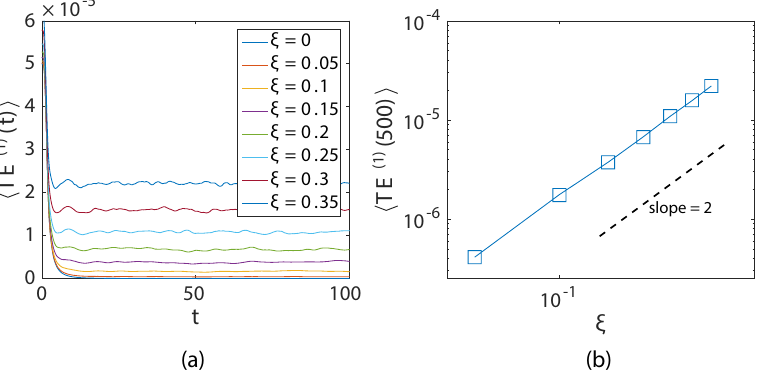
Figure 5. ( a ) Total energy (averaged over 500 ensembles) of the p = 1 particle with time for chains with different ξ . ( b ) Residual energy localized in the first particle measured at t ∼ =